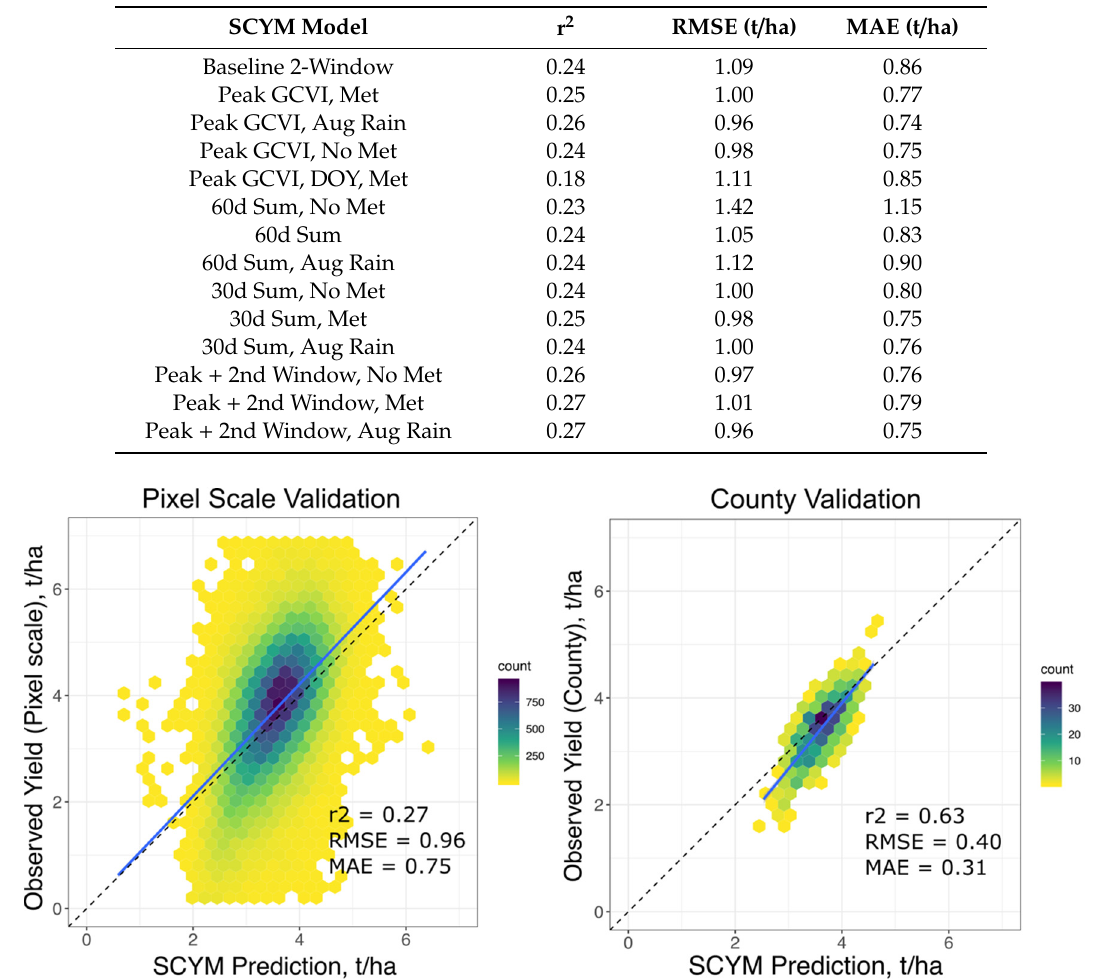
Table 6. SCYM Model Performance across Implementations. Baseline 2-Window refers to implementation from Lobell et al. 2015 [26]. “No met” means weather covariates not included. “Met” indicates the original four weather covariates (Methods). “Aug rain” models include only August rainfall as weather covariate.